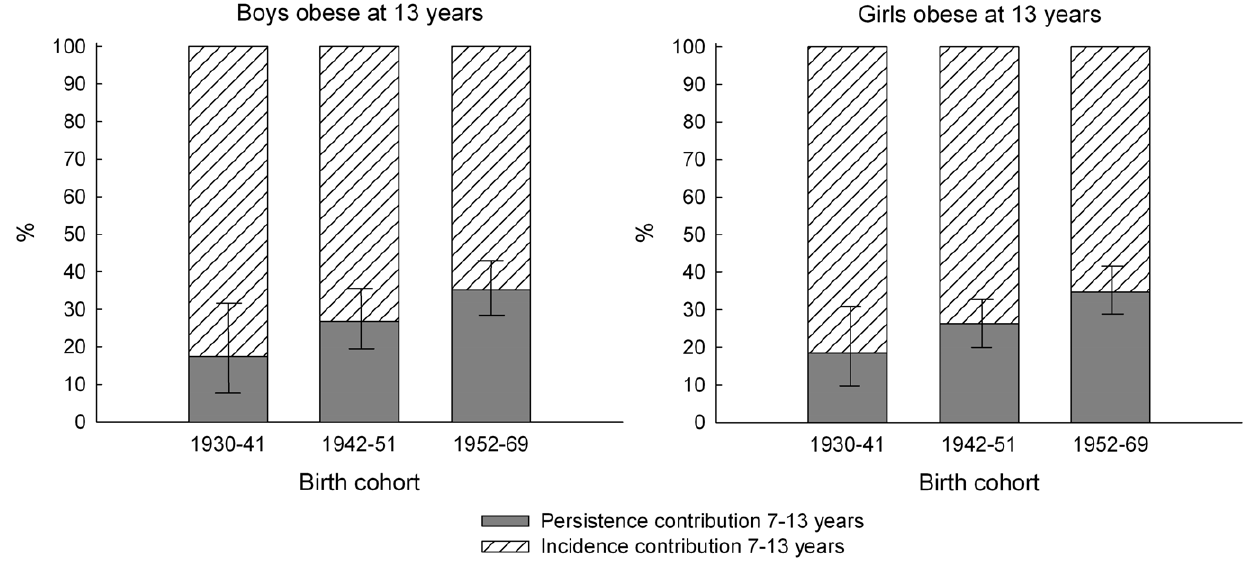
Figure 4. Trends in the incidence and persistence contributions to the prevalence of obesity at 13 years. The figure shows trends in the incidence and persistence contributions (in percent with 95% confidence intervals for the persistence contribution) to the prevalence of obesity by birth cohort (1930–69) among 367 13-year-old obese boys (left panel) and 438 13-year-old obese girls (right panel) in the Copenhagen School Health Records Register. Obesity was defined by International Obesity Task Force criteria. P values for non-linearity were 0.92 among boys and 0.97 among girls. P values for linearity were 0.01 among boys and 0.006 among girls.